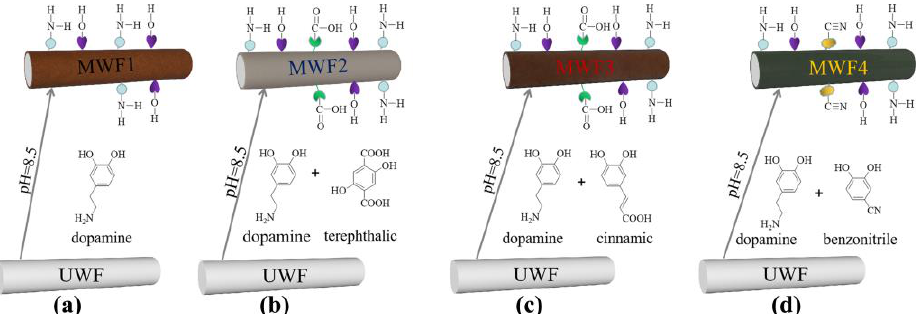
Figure 8. Schematic description of the coating on UWF. ( a ) dopamine, ( b ) dopamine and terephthalic, ( c ) dopamine and cinnamic, ( d ) dopamine and benzonitrile.